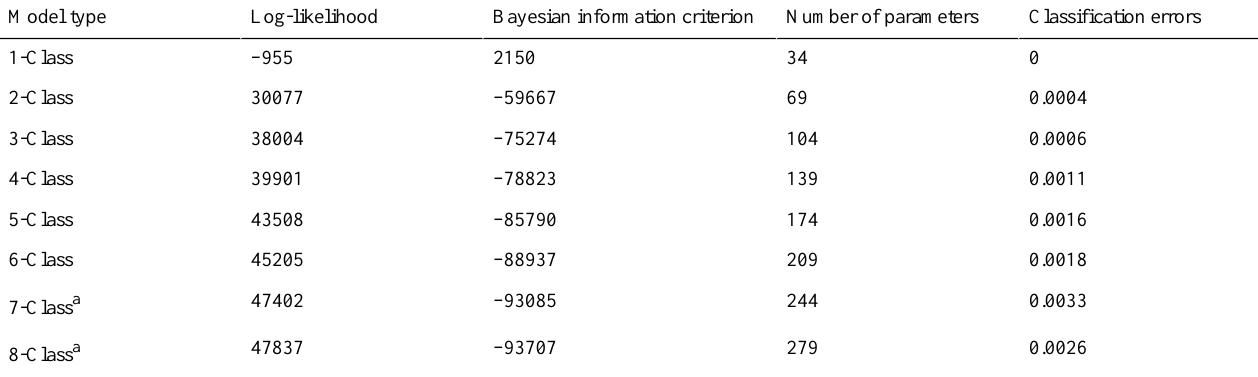
Table 2. Fit indices of the 1- to 8-class models used to select the final model. A 5-class solution was